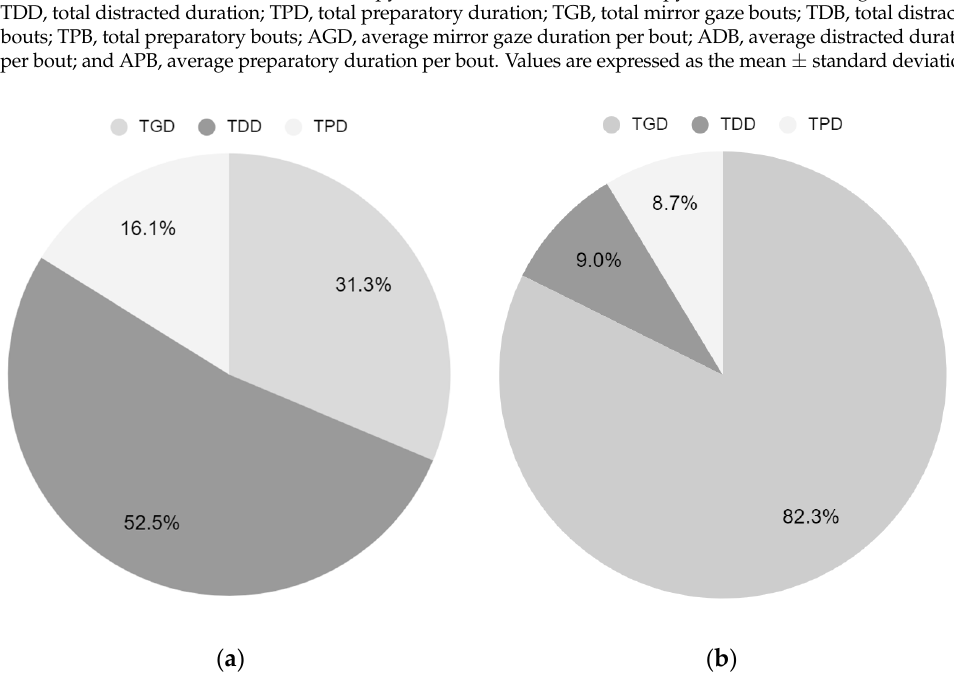
Figure 2. Percentage of total mirror gaze duration (TGD), total distracted duration (TDD), and total preparatory duration (TPD); ( a ) BMT and ( b ) UMT.